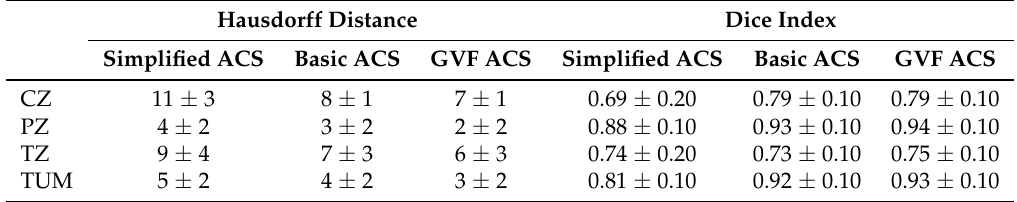
Table 1. Analyses of Hausdorff distance (in mm) and Dice index for the CZ, PZ, TZ and tumour area (TUM). Hausdorff